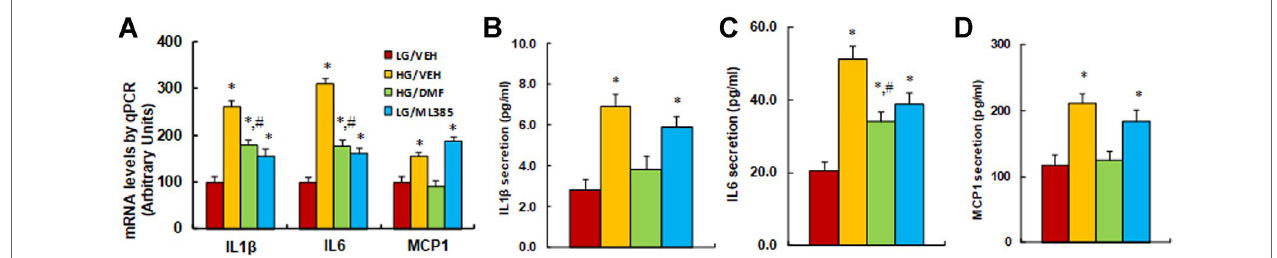
FIGURE 4 | Nrf2 activator DMF prevents, while Nrf2 blocker ML385 mimics, hyperglycemia-induced expression of proinflammatory cytokines. Rat macrophage cells were treated by either 5 µM Nrf2 activator DMF or 5 µM Nrf2 inhibitor ML385, then incubated in either low glucose (5 mM) or high glucose (25 mM glucose) continuously for 5 days, and the cells were harvested on day 5 for further analysis. (A) mRNA levels by qPCR, n = 4. (B) IL1 β secretion, n = 5. (C) IL6 secretion, n = 5. (D) MCP1 secretion, n = 5. * P < 0.05, vs LG/VEH group; # P < 0.05, vs HG/VEH group. Data were expressed as mean ±